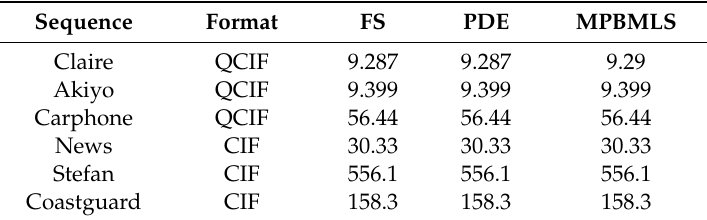
Table 3. Mean MSE with 50 frames.